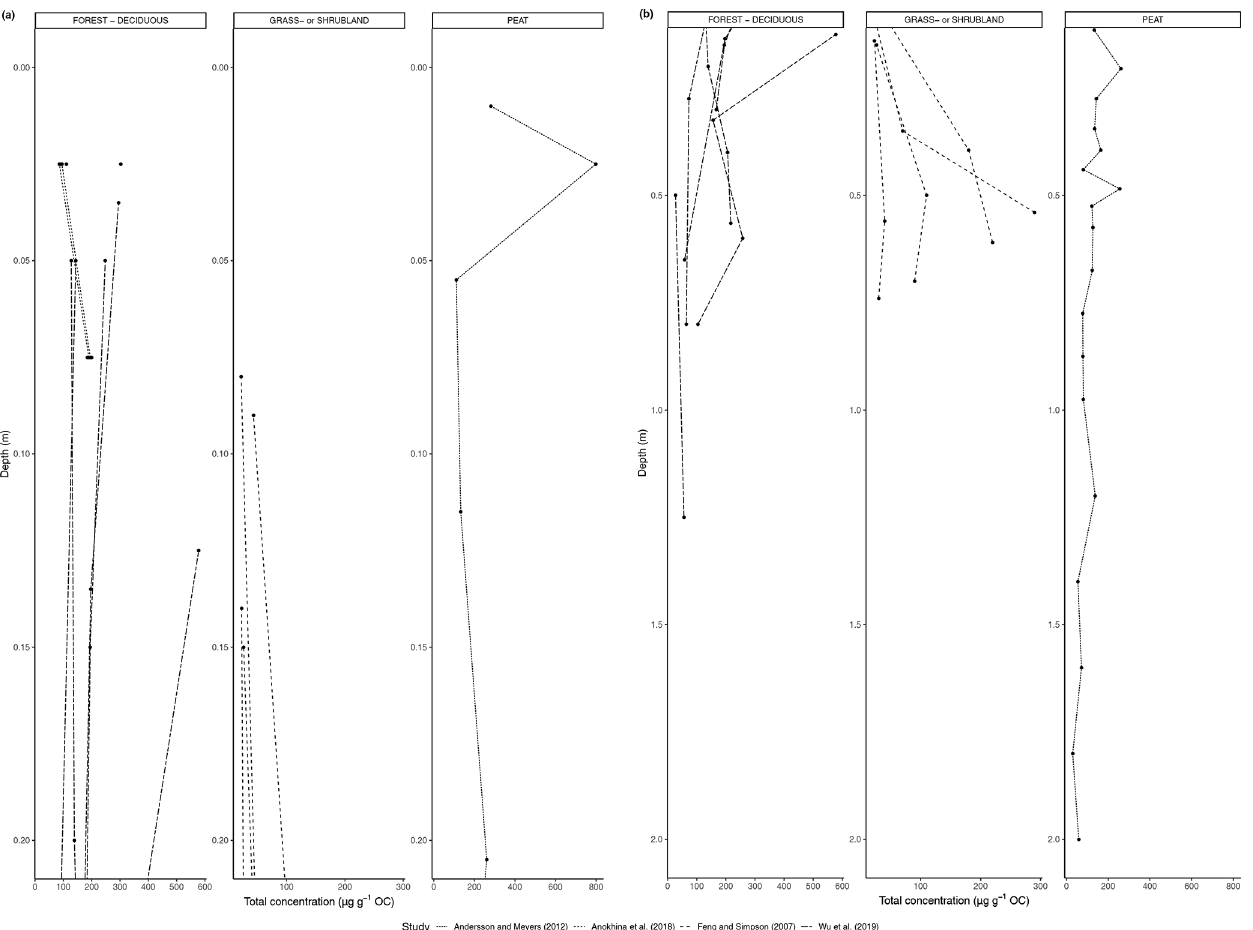
Figure 6. (a) Total concentration (µg/g OC) of n -alkanes in soil from 0 to 20cm. (b) Total concentration (µg/g OC) of n -alkanes in soil below